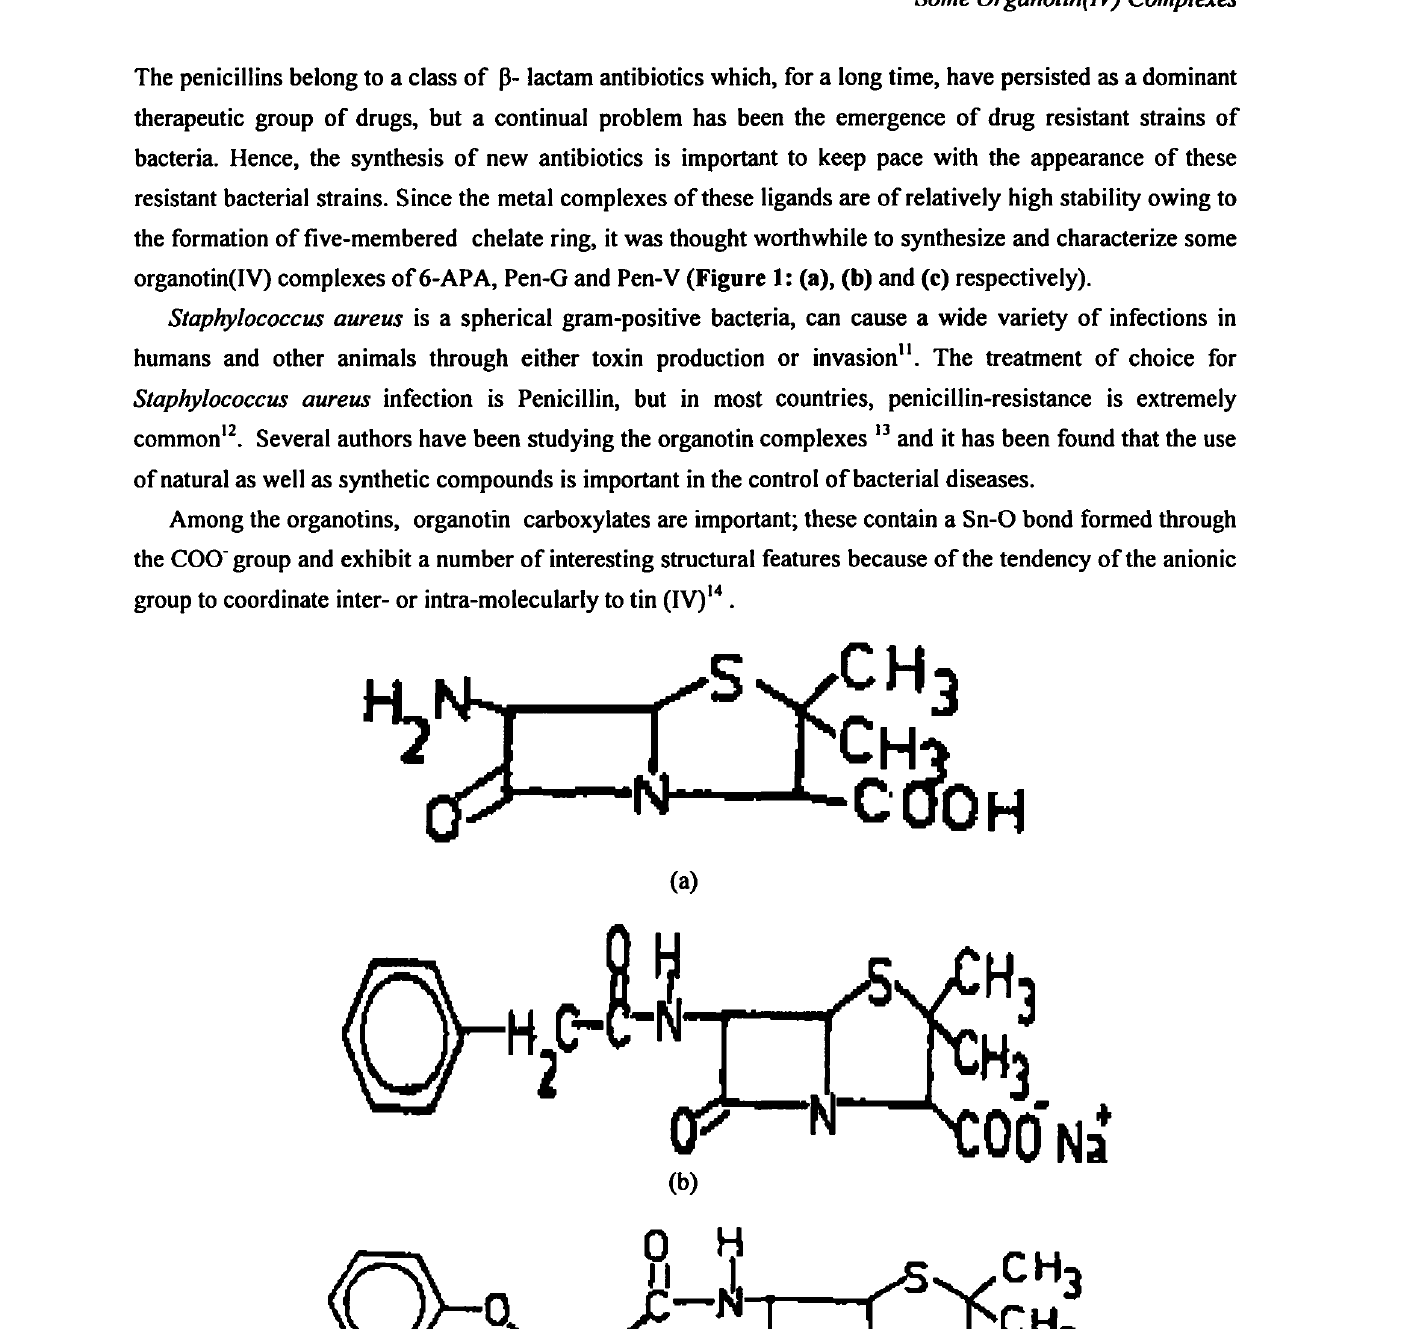
Fig. 1: Structure of (a) 6-APA, (b) Pen-G and (c) Pen